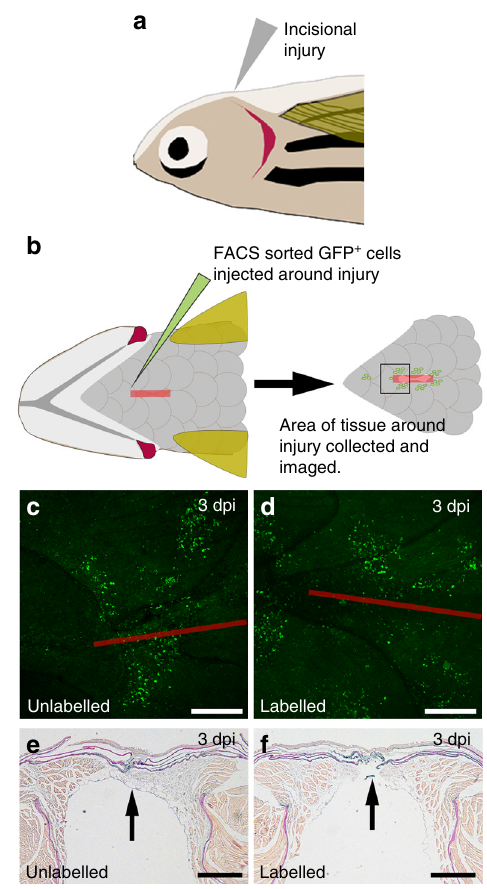
Fig. 7 In vivo zebra fi sh injury and [sc_thrombin][ox890] labelled GFP + fi broblast addition. Schematic representation of the in vivo adult zebra fi sh injury model. a Wildtype (non-transgenic) recipient zebra fi sh were anaesthetized and a 4 mm incisional injury made on the ventral upper thorax. A lateral view is shown. b Unlabelled or [sc_thrombin][ox890] labelled, FACS sorted GFP + fi broblasts were injected at six sites around the edge of the incisional injury. At the desired time-point, fi sh were sacri fi ced and the tissue surrounding the incision was fi xed, imaged and embedded for sectioning. A ventral view is shown. Ventral view of the area of tissue surrounding the incision at 3 dpi following transfer of c unlabelled or d [sc_thrombin][ox890] labelled GFP + fi broblasts. Similar numbers of cells were retained at all wounds. The red line depicts the approximate position of the incisional injury which is fully re-epithelialized at this stage. Sections through the injury region at 3 dpi following transfer of e unlabelled or f [sc_thrombin][ox890] labelled GFP + fi broblasts. No obvious differences were observed between wounds containing labelled or unlabelled cells. Arrows indicate the position of the incision. All scale